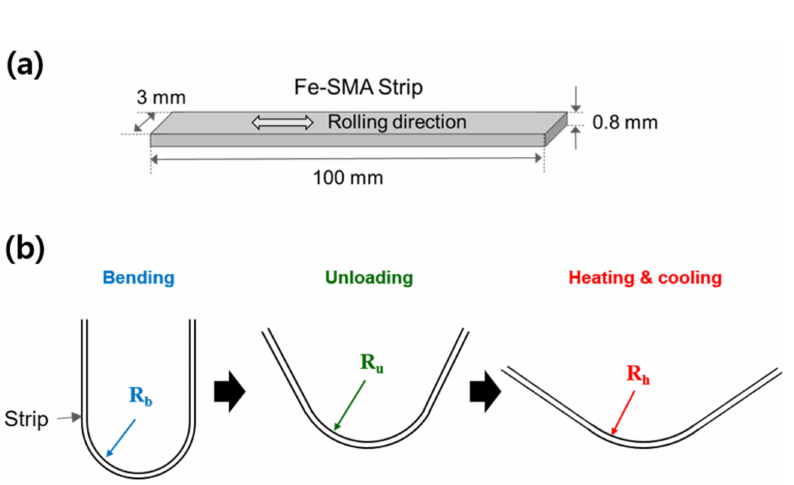
Figure 1. Schematics of bending tests: ( a ) geometry of the bending strip, and ( b ) strip bending and recovery